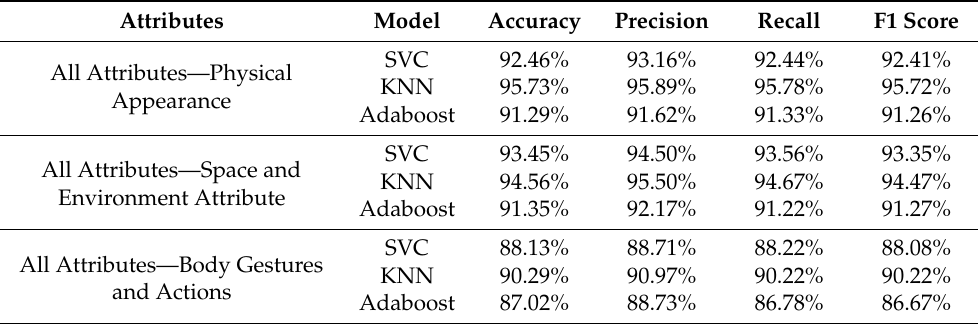
Table 22. Results when each set is